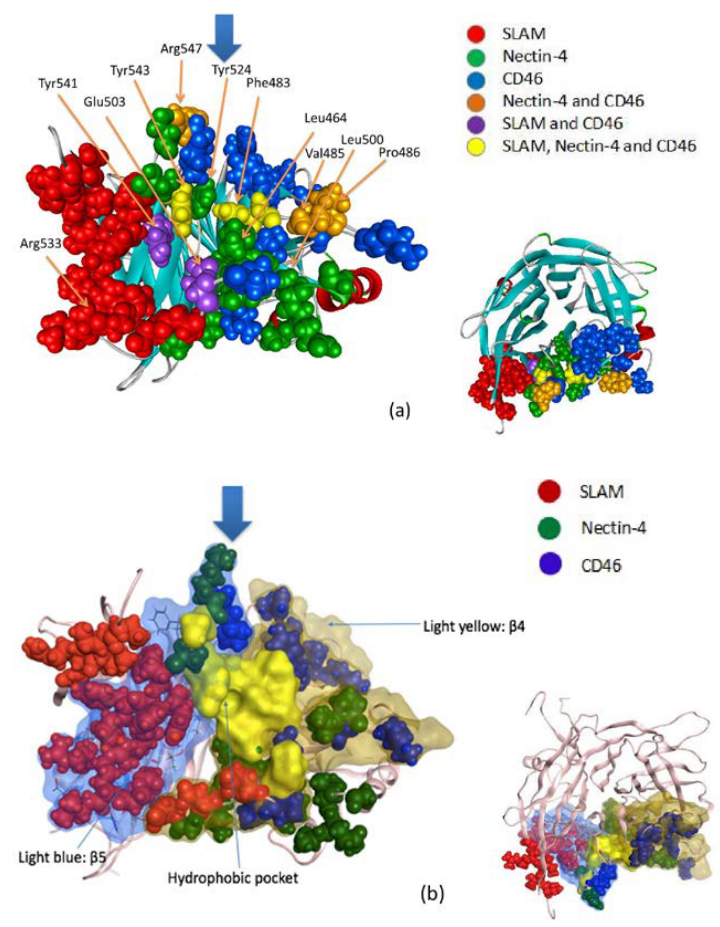
Figure 2. Amino acid residues on the interface of MVH binding to the three receptors. ( a ) Colored spheres represent the residues of MVH that show significantly attractive interactions with the three receptors; red, green, and blue spheres indicate the amino acid residues with high affinity to SLAM, Nectin-4, and CD46, respectively; orange indicates high affinity to both Nectin-4 and CD46; violet indicates high affinity to both SLAM and CD46; yellow indicates high affinity to all of SLAM, Nectin-4, and CD46. Some important residues are explicitly indicated. The smaller figure at the lower right shows the top view from the direction indicated by the thick arrow in the main figure. ( b ) Corresponding to ( a ), the hydrophobic pocket in MVH is represented in yellow from the same direction as ( a ). In addition, the β4 and β5 strand regions are depicted in light yellow and light blue, respectively. The smaller figure at the lower right shows the top view from the direction indicated by the thick arrow in the main figure.